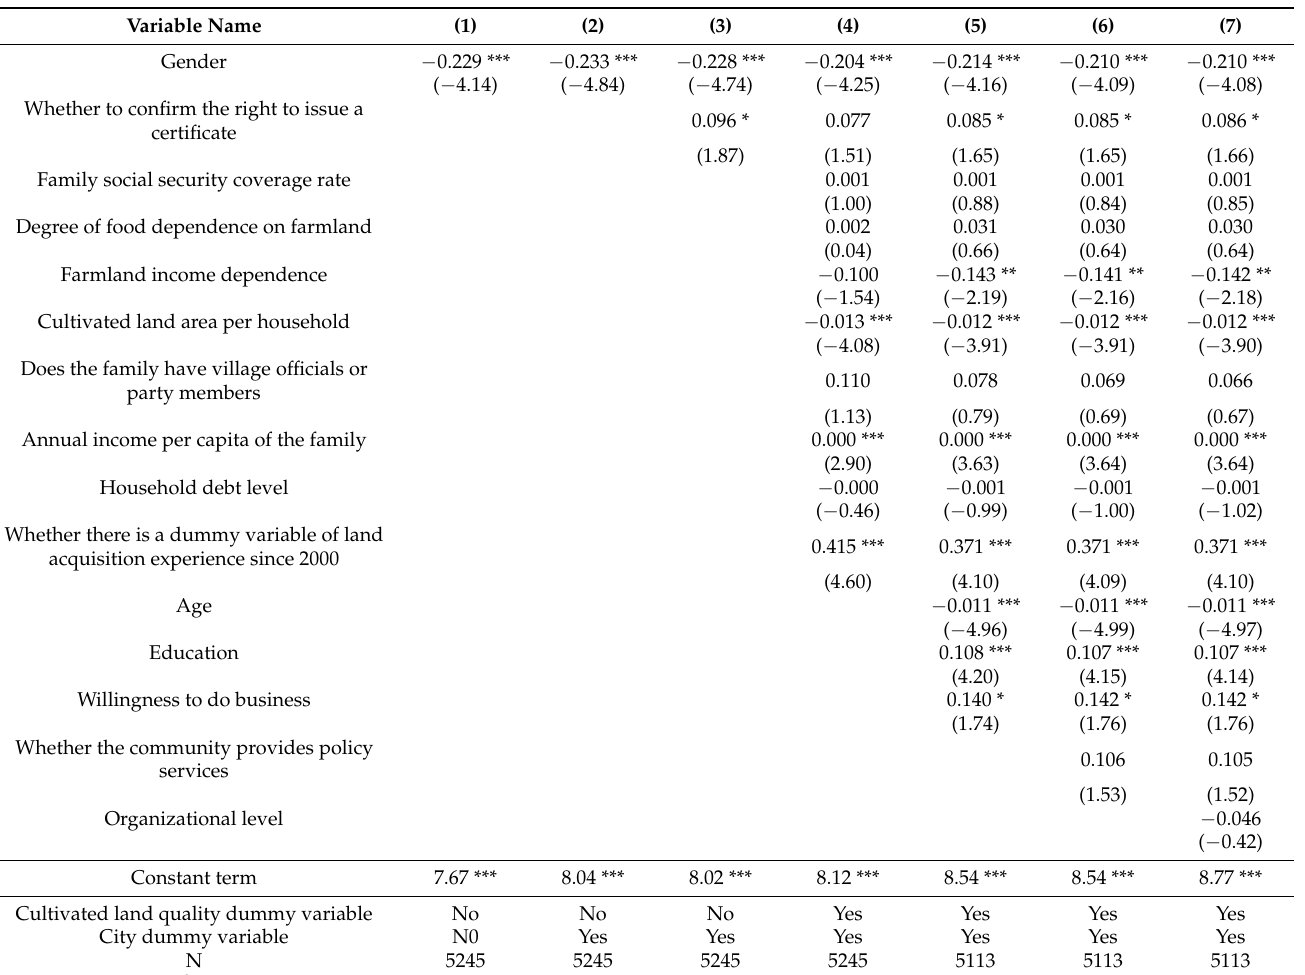
Table 4. Basic linear regression